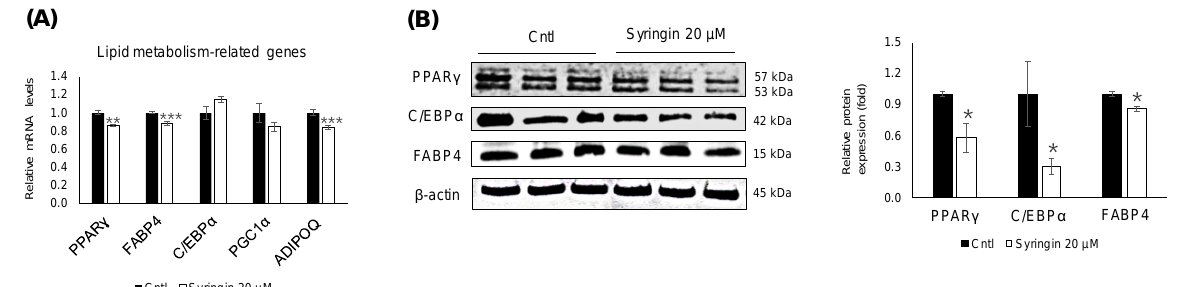
Figure 5. Effect of syringin on the expression of adipogenesis-related genes and proteins. ( A ) mRNA levels of adipogenesis-related genes. ( B ) Representative Western blot of adipogenic protein factors. The results are presented as means ± SEM of three independent experiments ( n = 3). The asterisk (*) indicates a significant difference between control and treatment groups tested by Student’s t-test. * p < 0.05, ** p < 0.01, and *** p < 0.001 vs. control (Cntl).